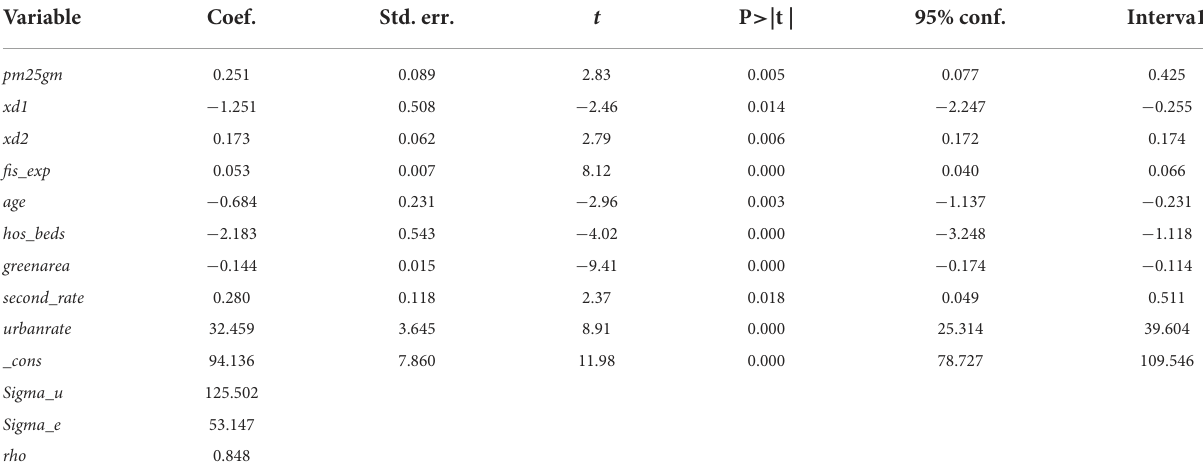
TABLE 6 Threshold regression results.